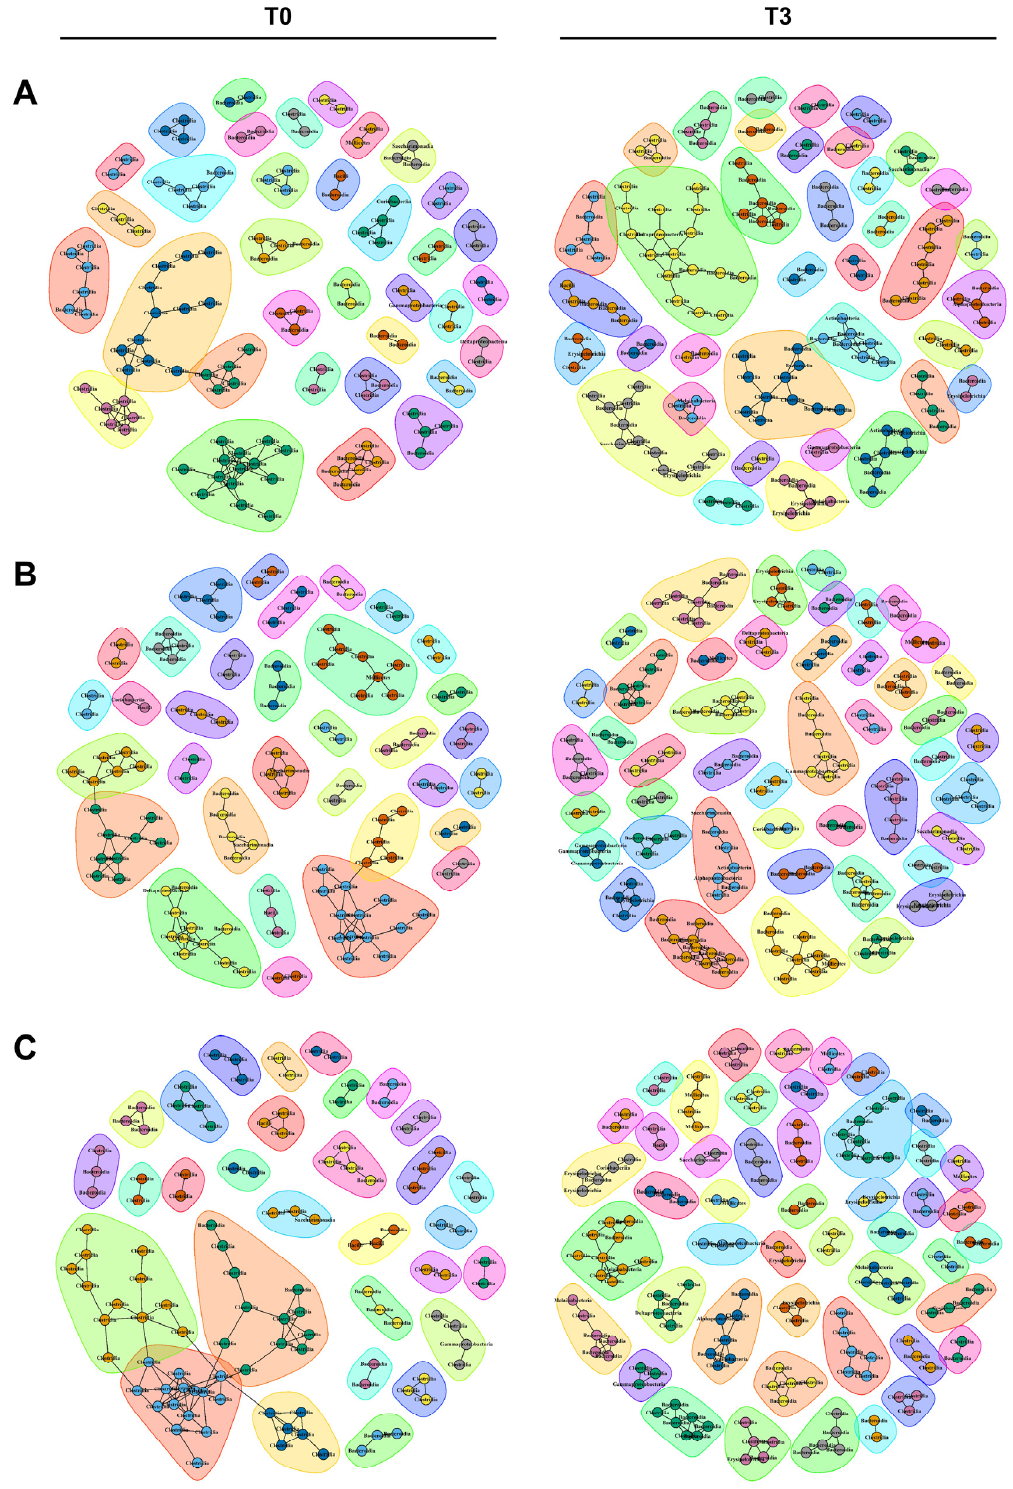
Figure 7. The co-occurrence network analysis by the ReBoot algorithm for the PBW, MBW, and NBW groups. The color-coded network graphs indicate the co-occurring and mutually exclusive interactions between OTUs. Black letters in the nodes correspond to the class level of the OTUs. Transparent shapes represent the network communities as determined by the Louvain modularity algorithm. ( A – C ) are PBW, MBW, and NBW groups before (T0, ( left )) and after the replacement (T3, ( right )) each.